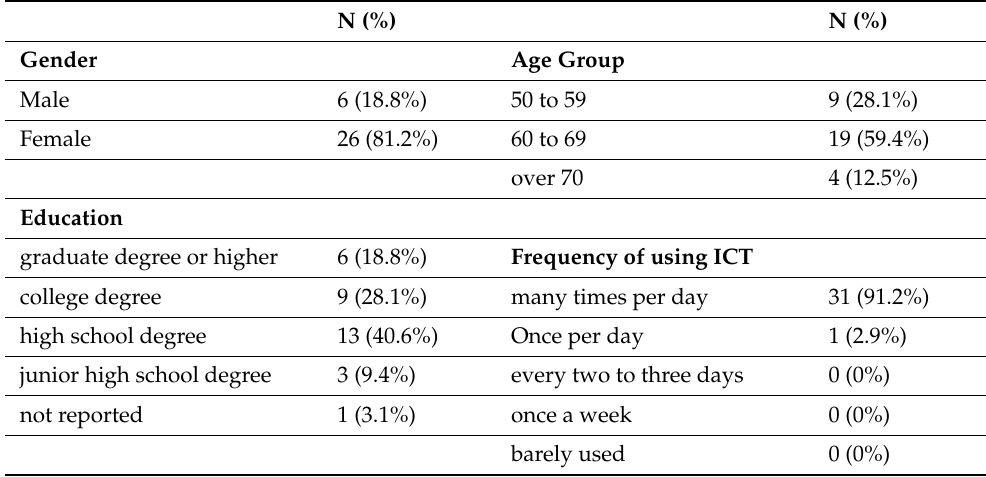
Table 1. Basic information about the participants of current